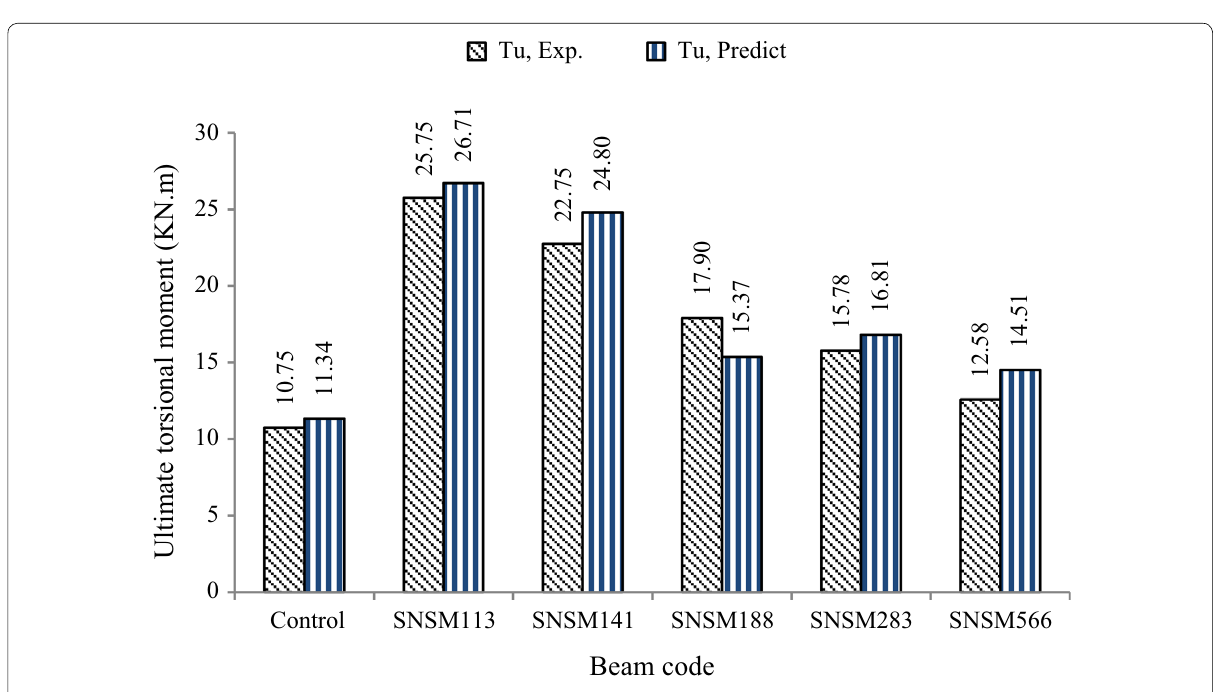
Fig. 15 Experimental versus analytical ultimate torsional moments at each concrete